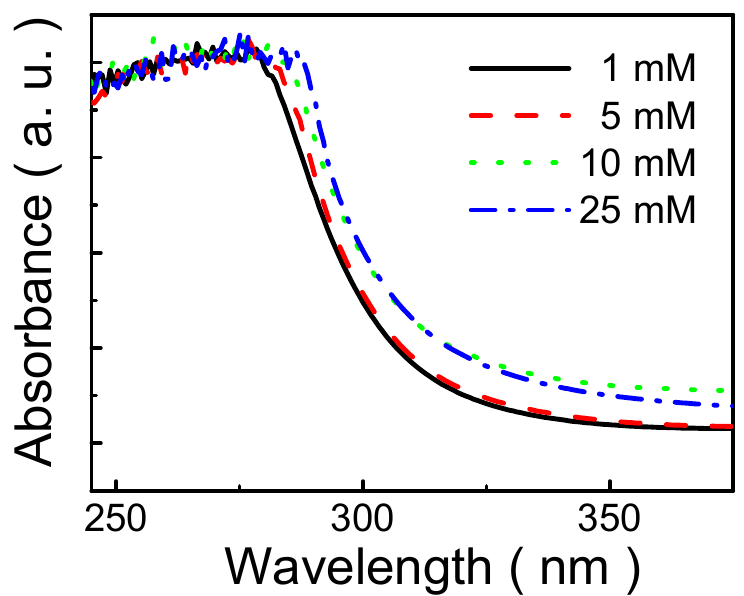
Figure 7. Absorbance spectra of organic thin films prepared by various solutions and annealed at 80 °C.